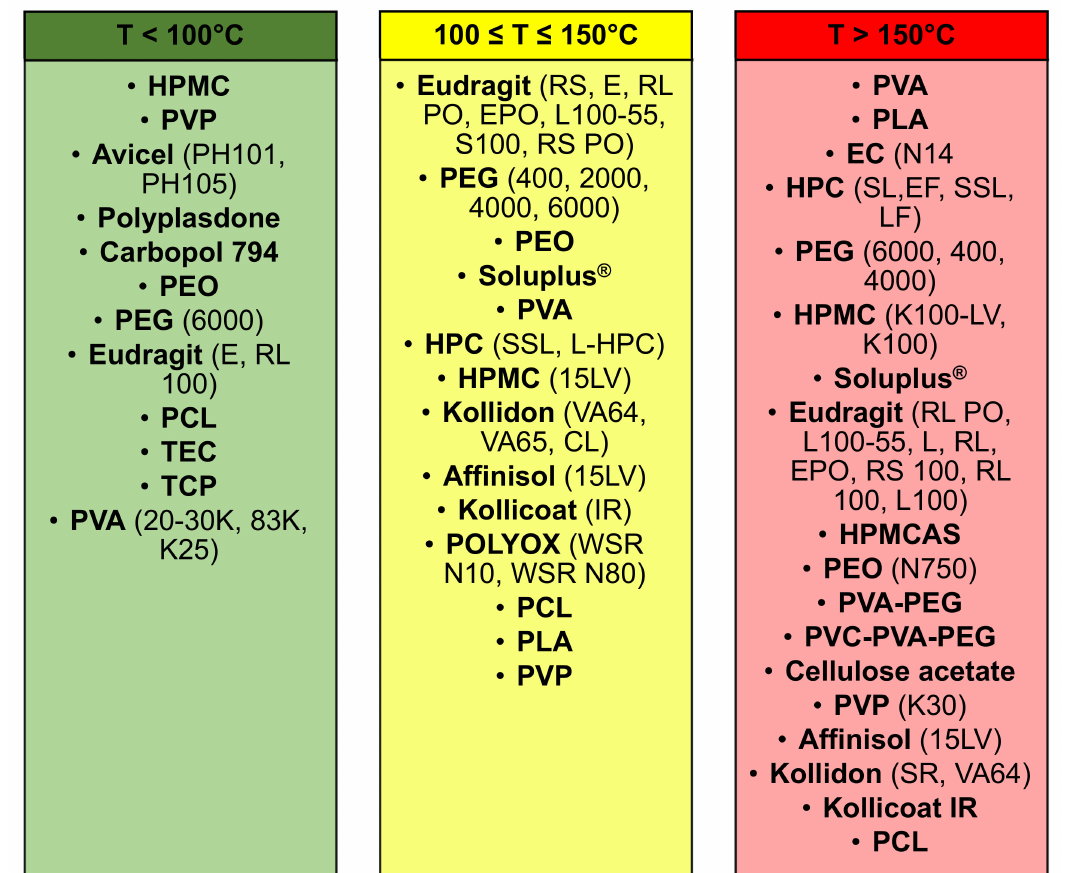
Figure 10. Classification of the polymers used with FDM 3DP technique based on three different printing temperature ranges: (1) T < 100 ◦ C (green), (2) 100 ◦ C ≤ T ≤ 150 ◦ C (yellow) and (3) T > 150 ◦ C